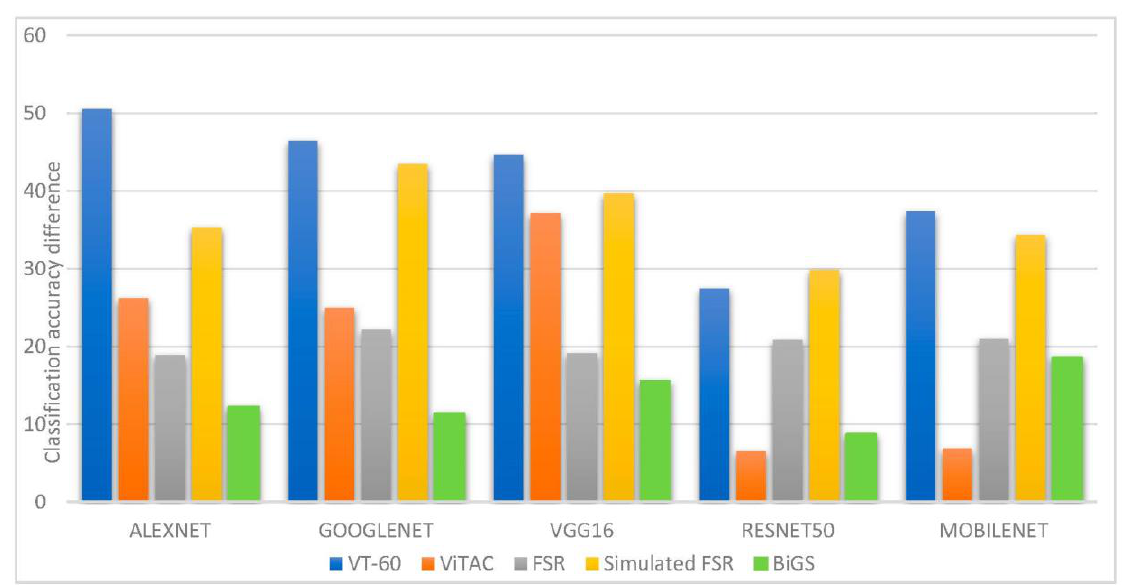
Figure 3. Accuracy differences between convolutional neural networks (CNNs) with frozen weights and CNNs with